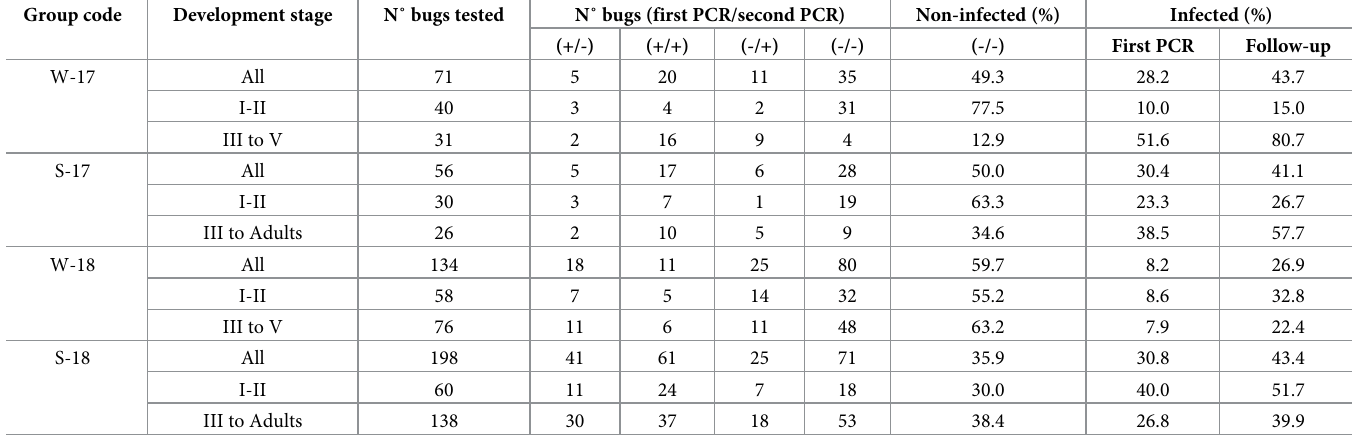
Table 2. PCR results and percentage of Trypanosoma cruzi infection in Mepraia spinolai collected in winter (W) and spring (S) of 2017 (17) and 2018 (18) surviving two feeding events, shown combined and by early (I-II) and late (III to adults) stages. Group